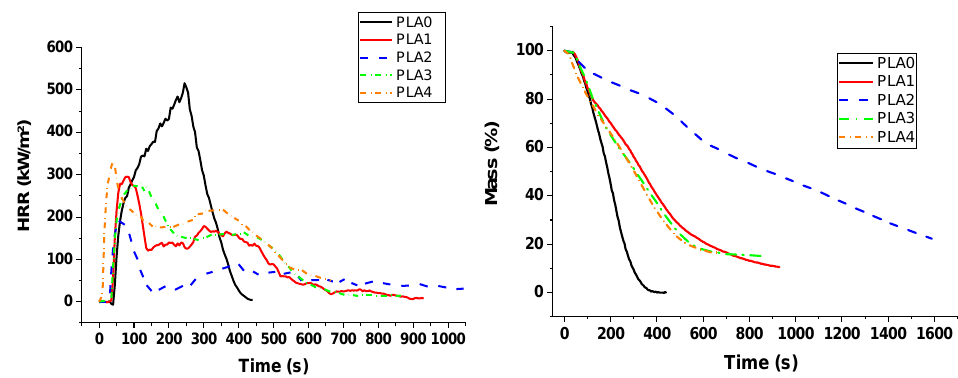
Figure 10. Heat release rate and mass for PUE/APP/S9 composites from cone calorimeter.